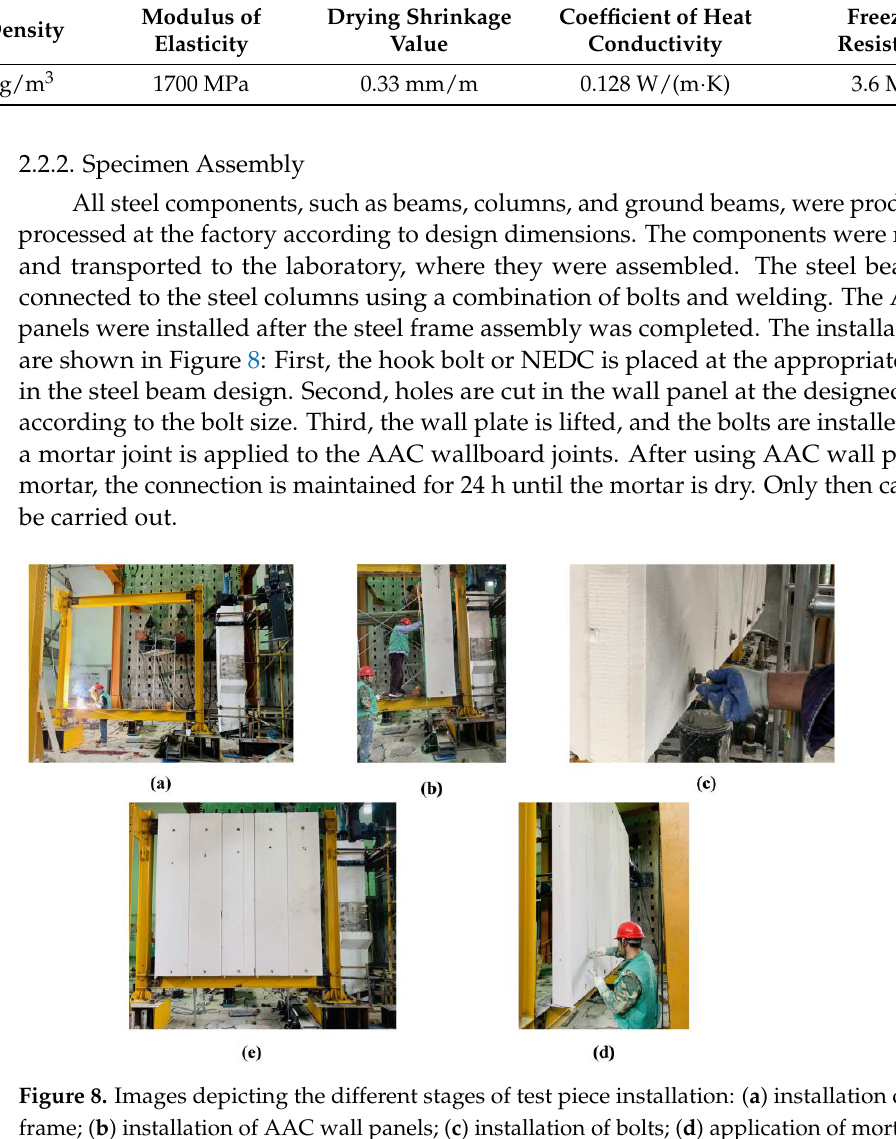
Figure 9. Diagram of the loading device used. The test employed a slow and continuous loading method. According to the provi- sions in the GB 50011-2010, three joints with a thickness of 2 mm were preloaded to ensure that there was no gap between the actuator and the steel frame. Consequently, the frame was installed, and the components were connected successfully. The interlayer displace- ment angles of 1/600, 1/500, 1/400, 1/200, 1/100, and 1/50 were used to control the loading. The test ended when key parts, such as the beam-column joints, were damaged or when